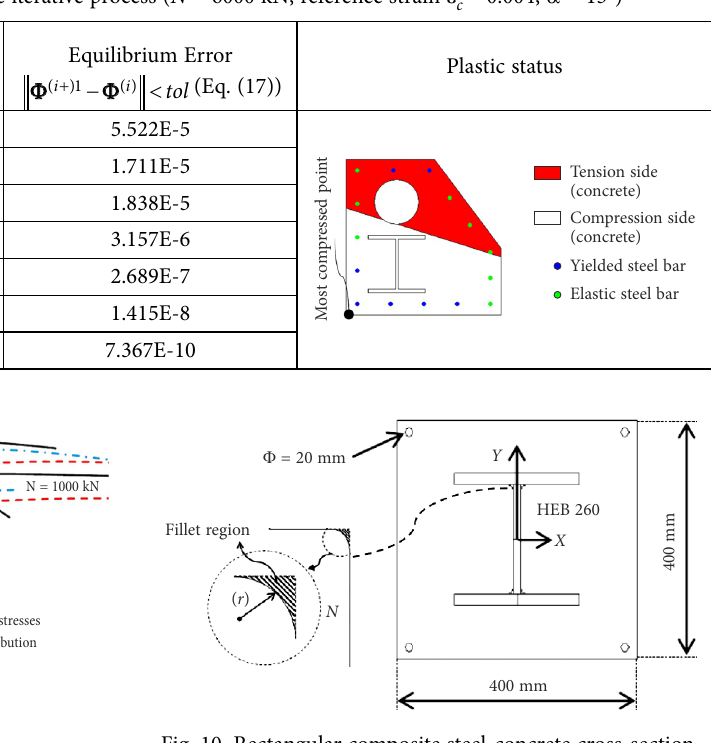
Fig. 10. Rectangular composite steel-concrete